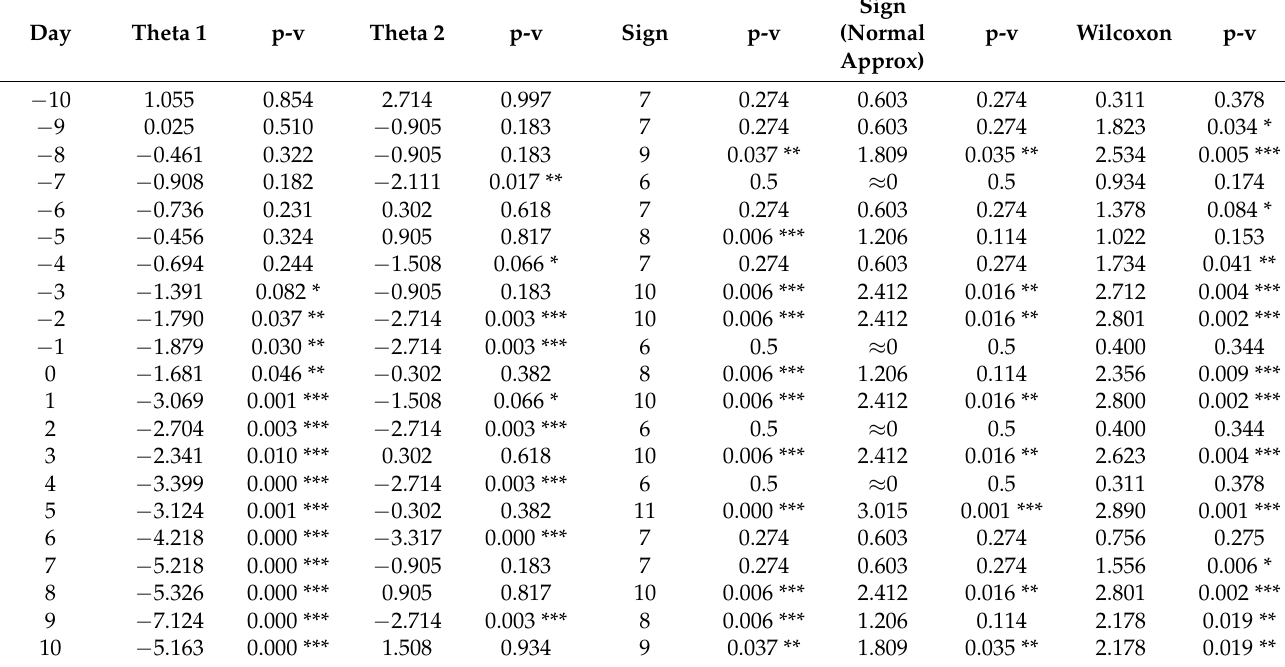
Table 6. Event study test, event